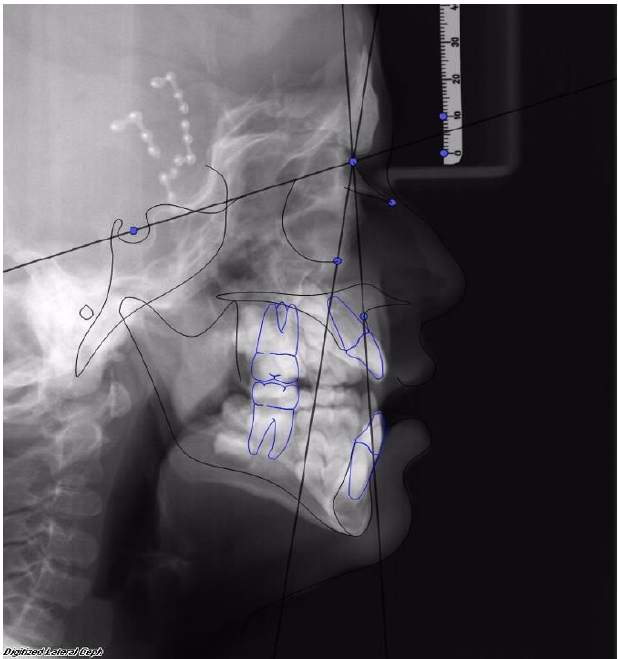
Figure 3. The s ame patient after 1 year from the end of treatment with MAC. SNA was 76° and SNOr Figure 3. The same patient after 1 year from the end of treatment with MAC. SNA was 76 ◦ and SNOr was 63°. was 63 ◦